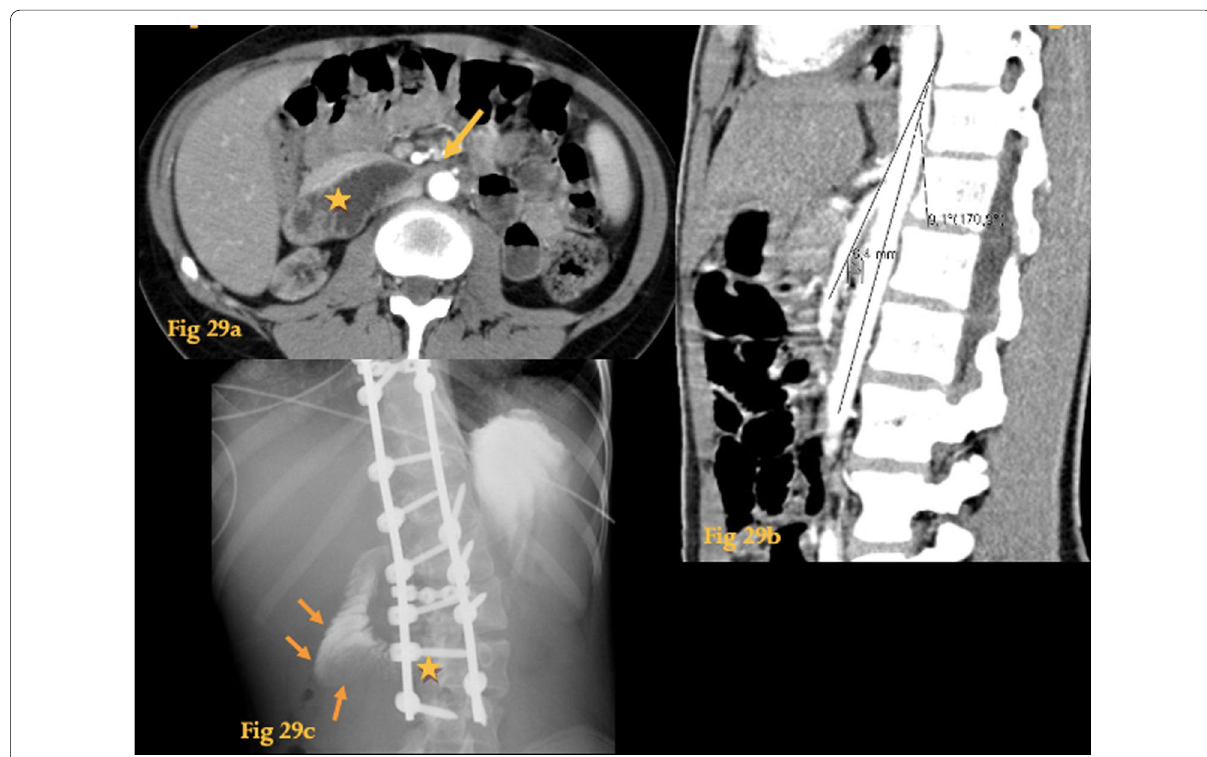
Fig. 29 Superior mesenteric artery syndrome. Arterial phase of an abdominal CT study of a female adolescent ( a ) shows dilatation of the duodenum (asterisk) upstream to the point where it crosses the SMA and the aorta (arrow). Note paucity of abdominal fat. Oblique sagittal reformation of another patient ( b ) shows reduction of the normal aortomesenteric angle (9º) and aortomesenteric distance (6 mm). Fluoroscopic series of a 10‑year‑old girl after surgical correction of kyphosis c shows obstruction at D3 with delayed passage of contrast through the stenosis (asterisk) and proximal dilatation of D2(arrows). This was due to SMA syndrome caused by lengthening of the vertebral